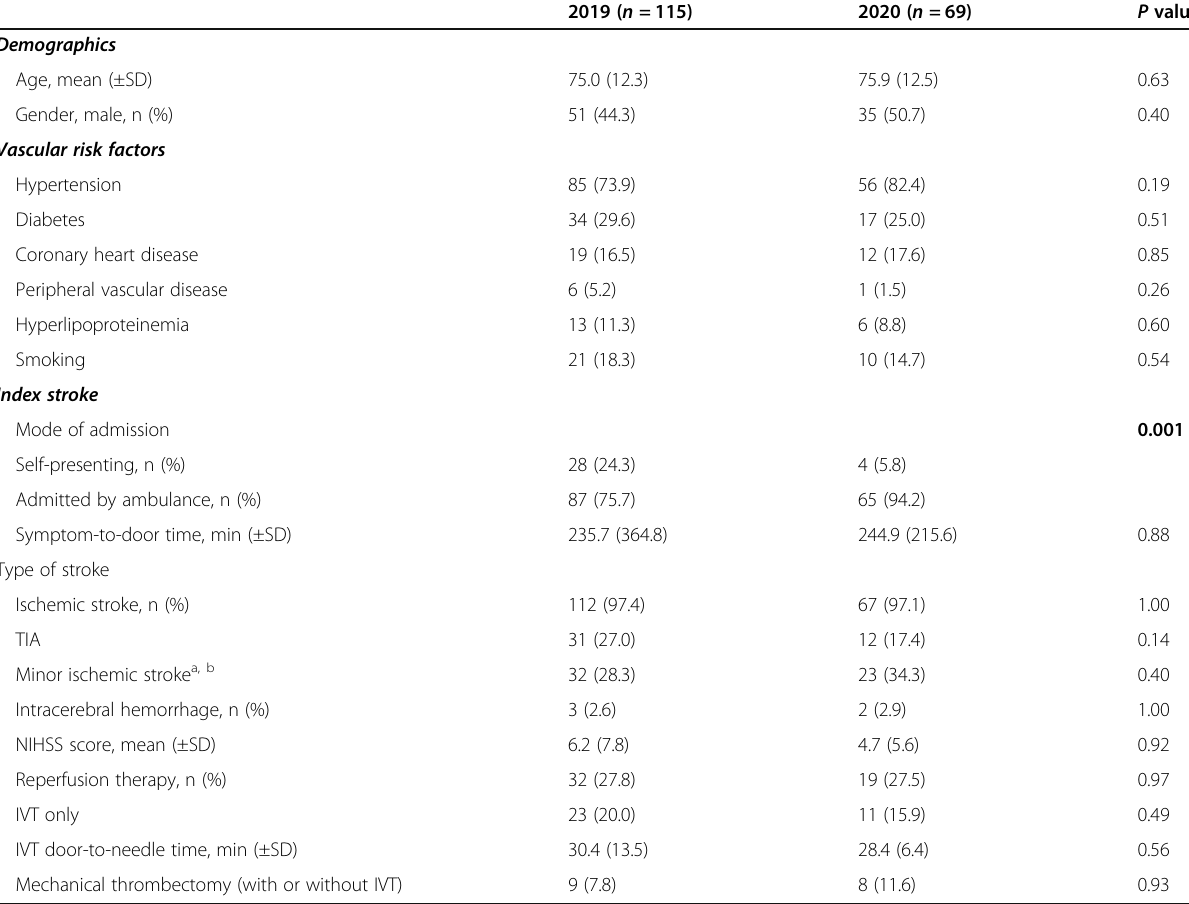
Table 1 Demographics, vascular risk factors and index stroke data of patients admitted in calendar weeks 12 – 17 in 2019 and 2020 2019 ( n =